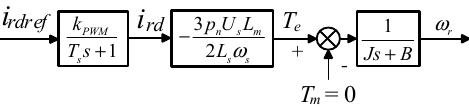
Figure 22. Control diagram of start up in pump mode.